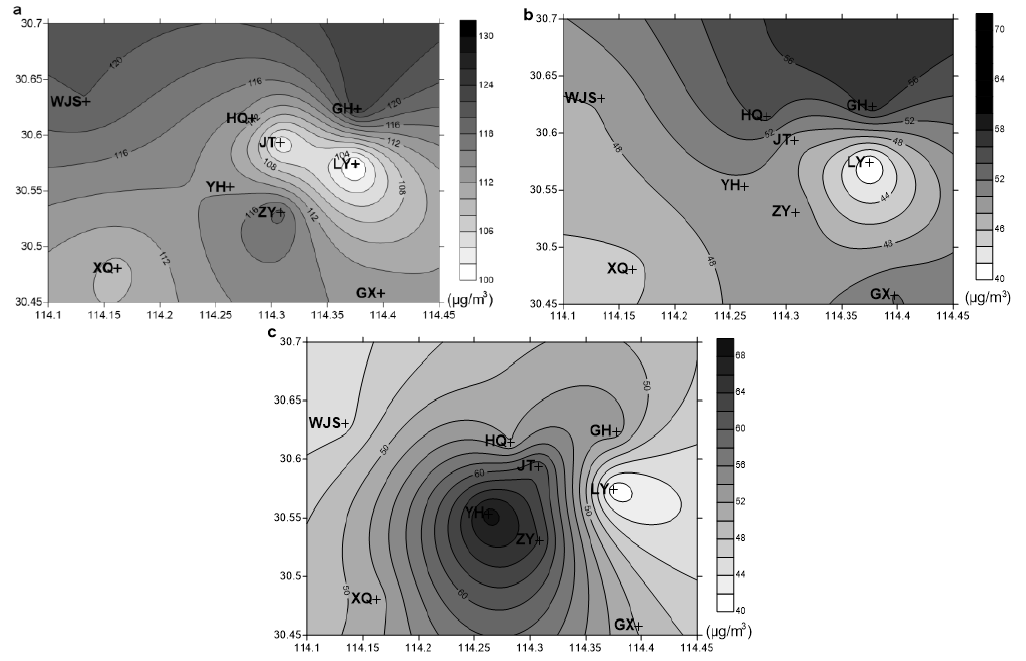
Figure 8. Spatial distribution of annual mean concentration of ( a ) PM 10 ; ( b ) SO 2 ; ( c ) NO 2 .